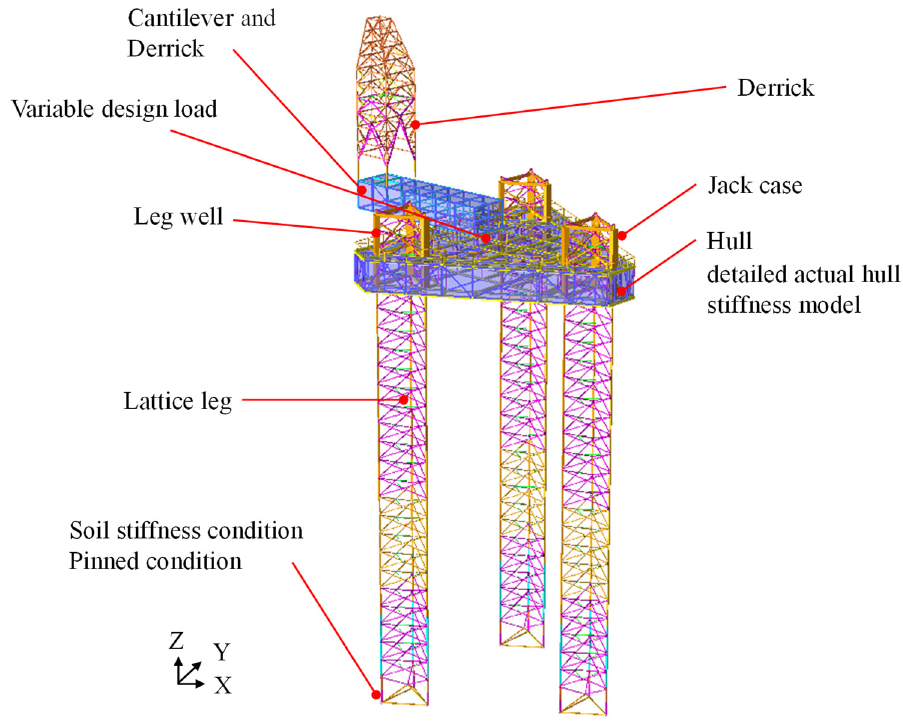
Figure 6. Structural members and analysis modeling